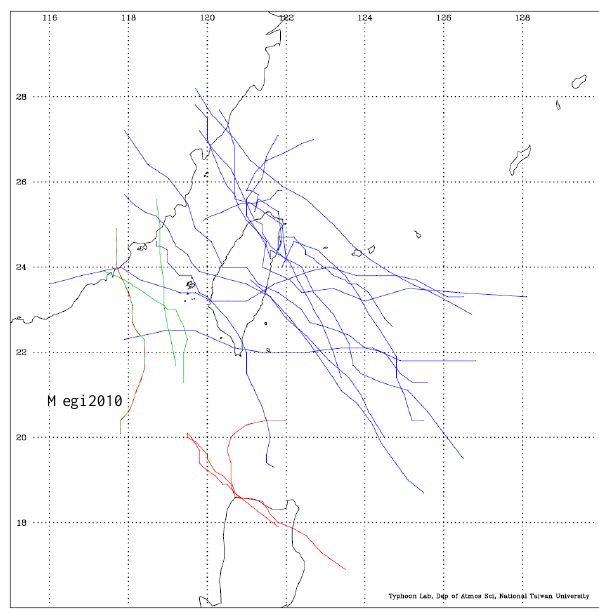
Fig 4. The track for the independent cases. Blue lines: westward moving typhoon, 2 Fig. 4. The track for the independent cases. Blue lines: westward Green lines: northward moving typhoon and red lines: the typhoon accompanied with 3 moving typhoon; green lines: northward moving typhoon; and red the northeasterly monsoon. 4 lines: the typhoon accompanied with the northeasterly